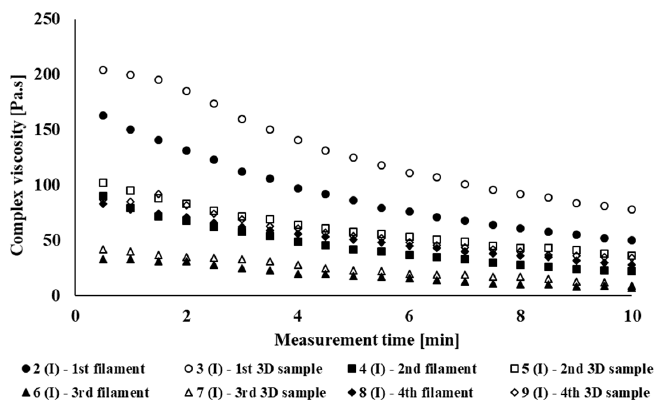
Figure 2. Dependence of complex viscosity on measurement time for NONOILEN ® 3D 3056-2 experimental samples prepared in laboratory conditions.